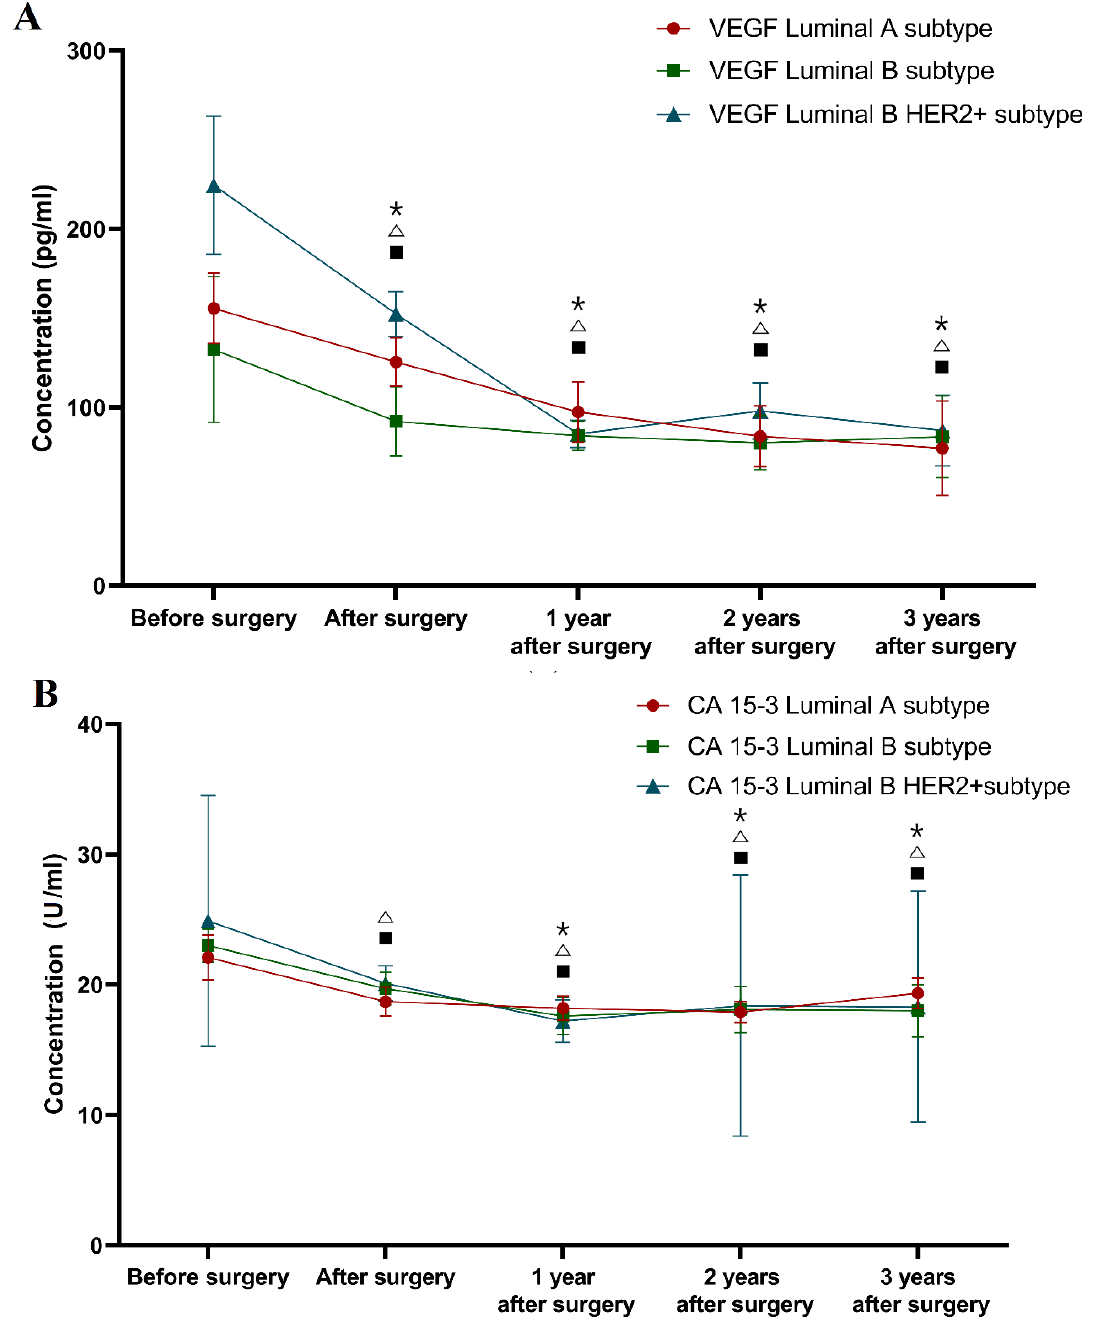
Figure 2. Plasma levels (median and standard error) of VEGF ( A ) and CA 15-3 ( B ) in a three-year follow-up of patients with breast cancer, by the molecular subtype of BC. * statistically significant difference from preoperative levels in luminal A subtype of BC group, (cid:52) statistically significant difference from preoperative levels in luminal B subtype of BC group, ▪ statistically significant difference from preoperative levels in luminal B HER2+ subtype of BC group.